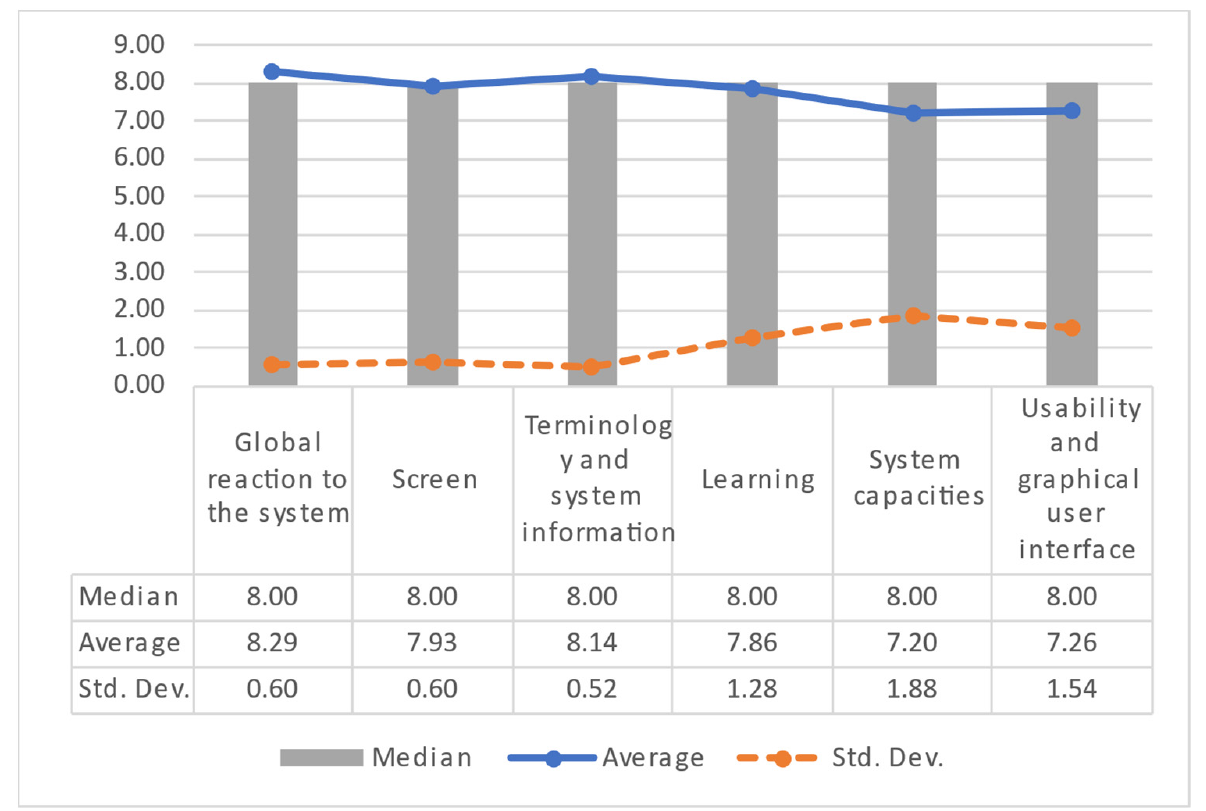
Figure 11. Patient user satisfaction results by category.